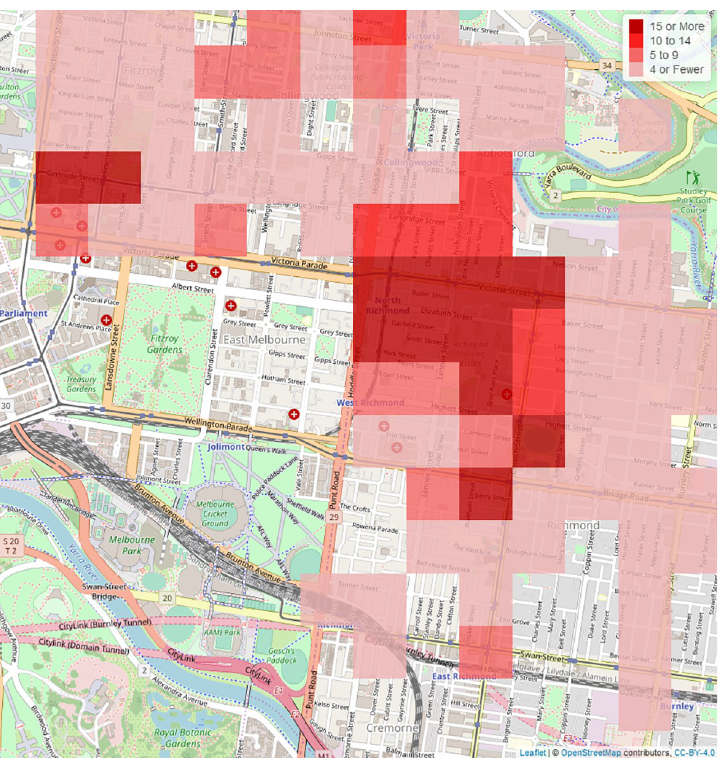
Fig 3. The number of opioid-related ambulance attendances in one local government area in metropolitan Melbourne. Ambulance attendances are shown within 250 metre squares, based on GPS data. The map source information is provided by OpenStreetMaps